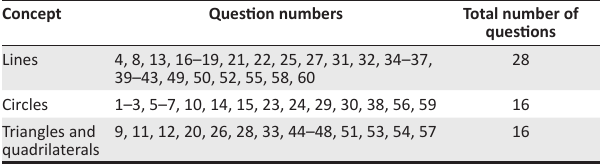
TABLE 6: The different concepts tested in the terminology test. Concept